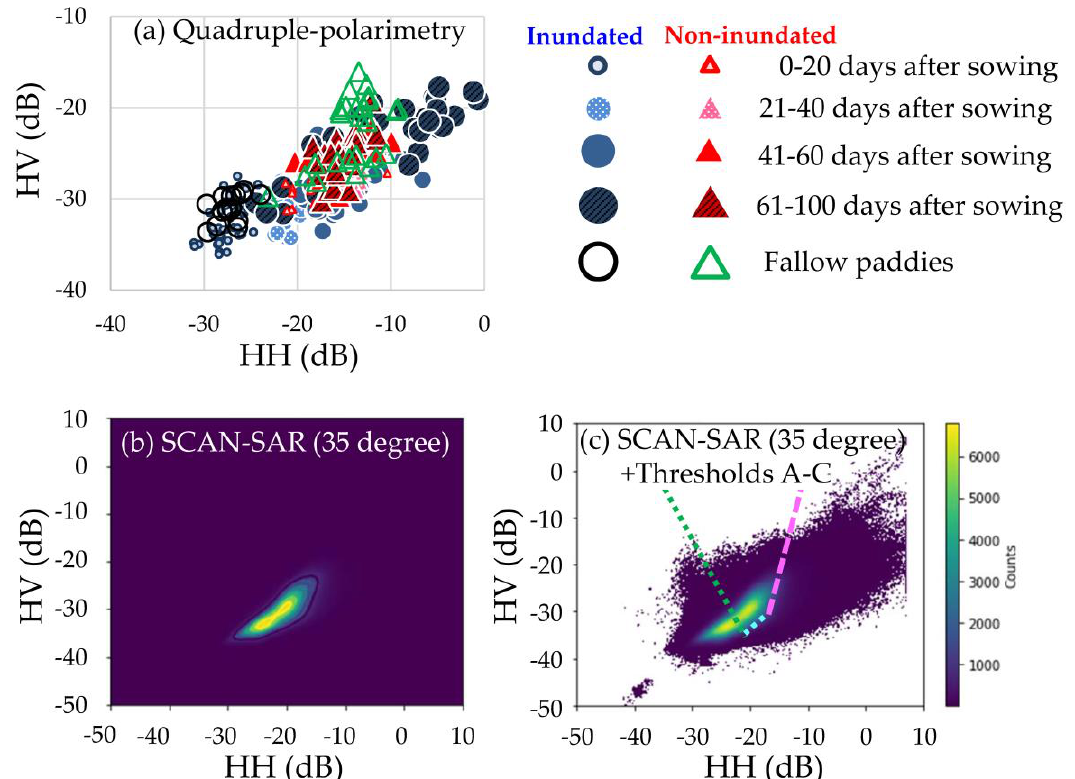
Figure 2. Scatter plot of ALOS-2/PALSAR-2-quadruple polarimetric high spatial resolution (3 m) data of the backscattering coefficients of HH and HV microwave (n = 313, ( a )), a sample of the 2D histogram of ScanSAR data illustrated with contours ( b ), and the noncontour histogram with three thresholds A – C ( c ). The horizontal axes in the subfigures ( a – c ) indicate HH σ 0 values, and the vertical axes indicate HV σ 0 values. The lightest/smallest closed blue circles (n = 48) in subfigure ( a ) indicate the mean value among 25 – 30 pixels of an inundated paddy ROI (up to 20 days after sowing). The second lightest/smallest dotted blue circles (n = 30) represent 21 – 40 days after sowing. The third lightest/smallest closed blue circles (n = 40) represent 41 – 60 days after sowing. The darkest hatched blue circles (n = 32) represent 61 – 100 days after sowing. The black open circles (n = 16) represent the fallow period, just after plowing, or inundated fallow. The smallest red open triangles (n = 36) in the subfigure (a) indicate the mean value among 25 – 30 pixels of a noninundated paddy ROI (0 – 20 days after sowing). The second lightest/smallest dotted red triangles (n = 28) represent 21 – 40 days after sowing; the third lightest/smallest closed red triangles (n = 26) represent 41 – 60 days after sowing; the darkest hatched red triangles (n = 30) represent 61 – 100 days after sowing; and the open green triangles (n = 27) represent dry soil and rice stubble during the fallow seasons. All values plotted in subfigures ( b , c ) were collected from all pixels whose incidence angles ranged from 34.5 to 35.4 degrees. The green dotted line, light-blue dotted line and pink broken line in subfigure (c) indicate threshold A, threshold B, and threshold C, respectively. The equations for thresholds A – C are described in Equations (12) – (14). The color bars of subfigures (b,c) indicate the pixel count density of each plot (25 m spatial resolution).